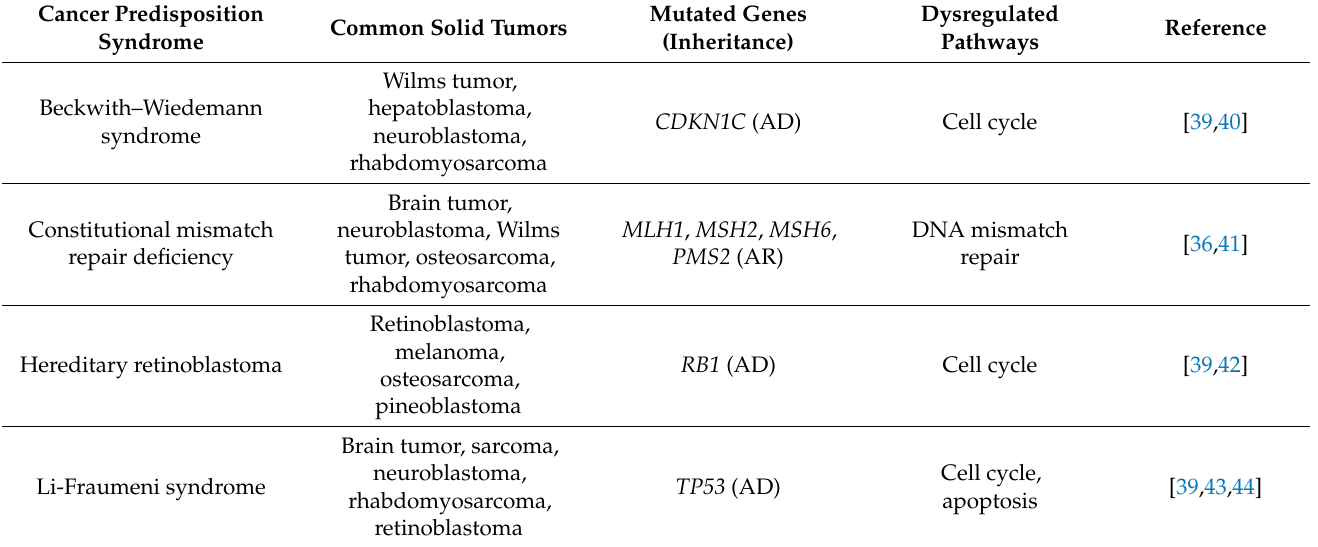
Table 1. Mutated genes and dysregulated signaling pathways in selected cancer predisposition